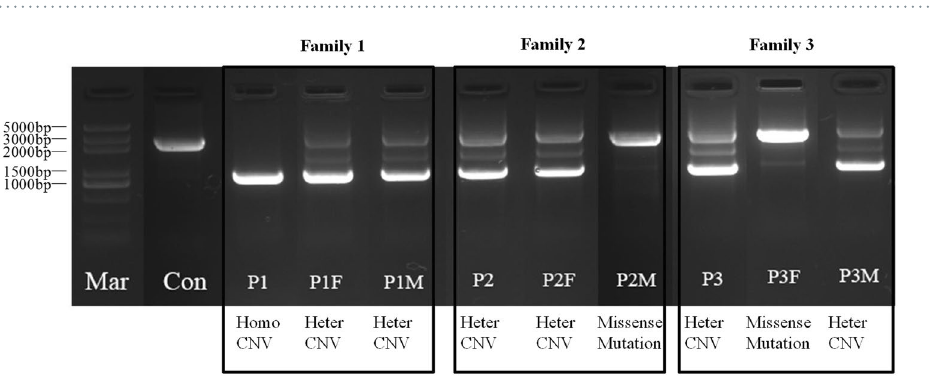
Figure 4. Electropherogram of PCR products of three MEB families. The normal control (Con) had only the predicted size 2476-bp band, the same as patient 2 ′ s mother (P2M) and patient 3 ′ s father (P3F) with only one missense mutation. Patient 1 (P1) with the homozygous (Homo) CNV had only one smaller size 886-bp band, while patient 1 ′ s parents (P1F, P1M), patient 2 (P2), patient 2 ′ s father (P2F), patient 3 (P3) and patient 3 ′ s mother (P3M) with heterozygous (Heter) CNV had both the predicted size 2476-bp band and the smaller size 886-bp band. Full-length gels are presented in Supplementary Figure S2.